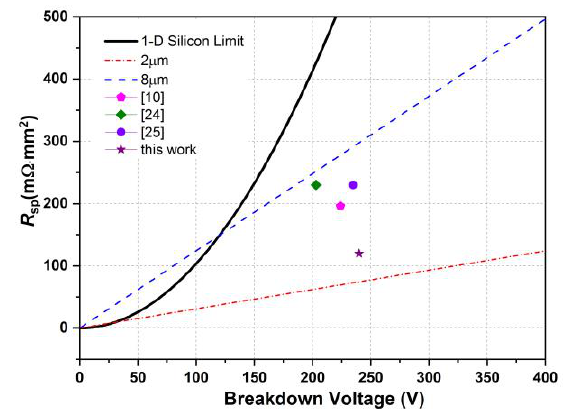
Figure 9. Performance comparing of one-dimensional silicon limit, two-dimensional charge-coupling limits for the pitches of 2 and 8 μm. Some references are [10,24,25] and this work.